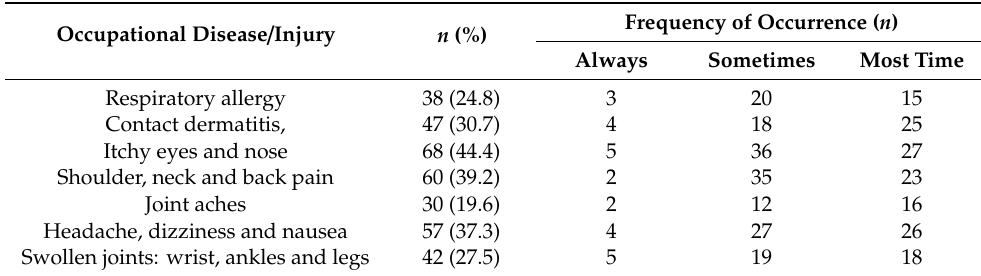
Table 2. Occupational diseases su ff ered.